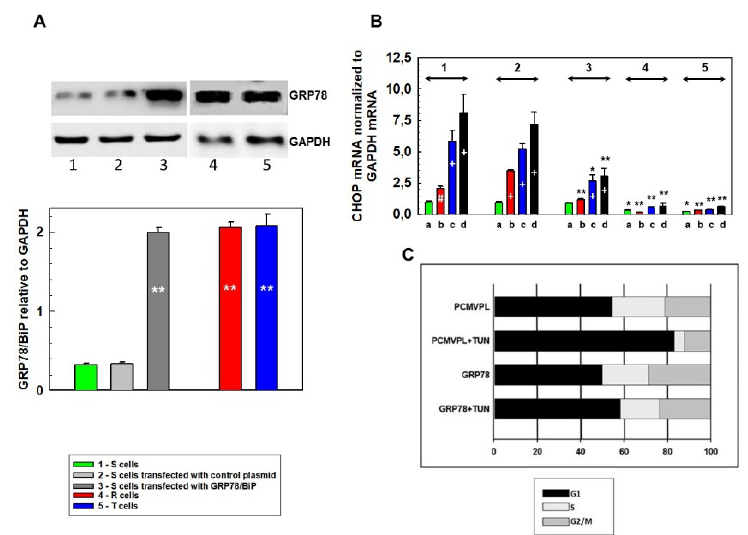
Figure 8. E ff ect of S cell transfection with the GRP78 / BiP gene on CHOP mRNA transcription and cell cycle progression: ( A ) Western blot detection of GRP78 / BiP in 1. S cells untransfected; 2. S cells transfected with pCMV-PL control plasmid; 3. S cells transfected with pcDNA3.1( + )-GRP78 / BiP plasmid, 4. R cells, and 5. T cells. Data are representative of three independent measurements, and GAPDH was used as an internal control. Protein bands were quantified by densitometry, GRP78 / BiP was normalized to GAPDH, and the data are expressed as the mean ± S.E.M. of three independent measurements in the column plot. Significance: Data di ff er from value obtained for untrasfected S cell at the level ** p < 0.002. ( B ) qRT-PCR quantification of CHOP transcripts in untransfected and transfected S cells, R cells, and T cells (symbols 1–5 are described above). Cells were incubated with tunicamycin for 0 (a), 4 (b), 8 (c), and 24 (d) hours. GAPDH was used as an internal control, and the data are expressed as the mean ± S.E.M. Transcription of DDIT3 gene (encoding CHOP) obtained for untransfected S cells, which were untreated with tunicamycin, was arbitrarily taken as one. Data di ff er from value obtained without incubation in the presence of tunicamycin (a) at the level # p < 0.02, + p < 0.002; data di ff er from that correspondingly obtained for S cell transfected with control plasmid (2) at the levels * p < 0.02 and ** p < 0.01. ( C ) Proportion of S cells transfected either with pCMV-PL (PCMVPL) control plasmid or pcDNA3.1( + )-GRP78 / BiP (GRP78) plasmid in di ff erent phases of the cell cycle (G1, S, and G2 / M) after 24 h of incubation with 0.1 µ M tunicamycin. Data are representative of three independent